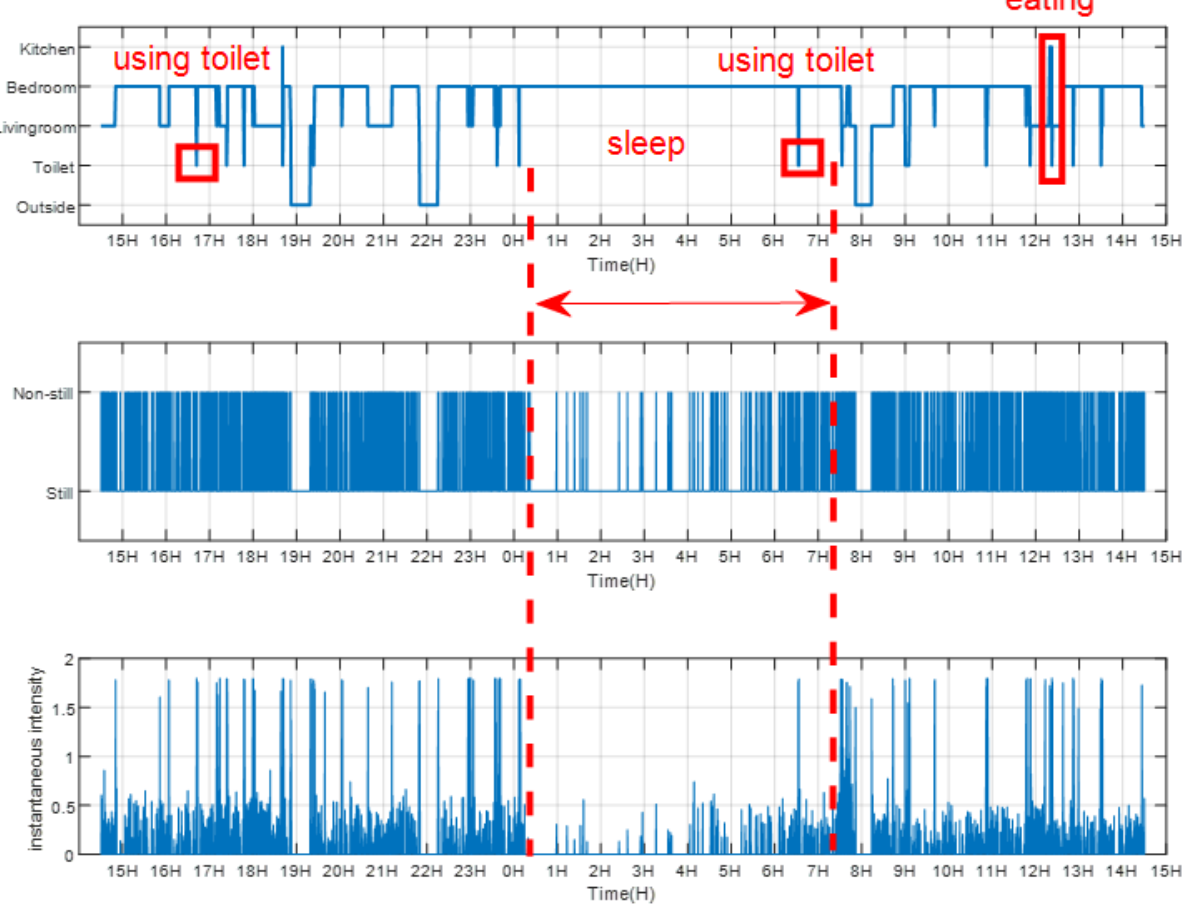
Figure 16. A continuous 24 h of basic information of human